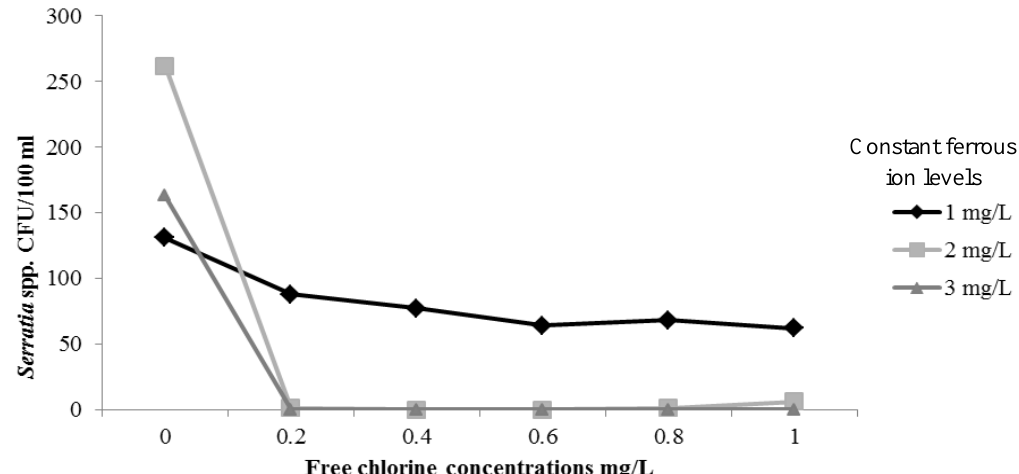
Figure 2: Inhibition of S. marcescens at different Cl 2 concentrations under constant ferrous ions concentrations of 1, 2 and 3 mg/L.